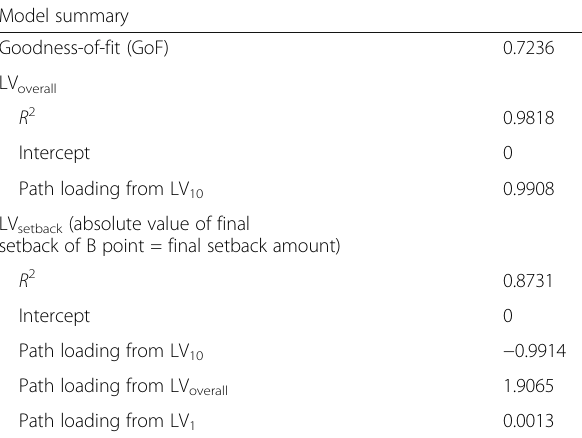
Table 5 Summary statistics for inner model of derived PLS-PM Model summary